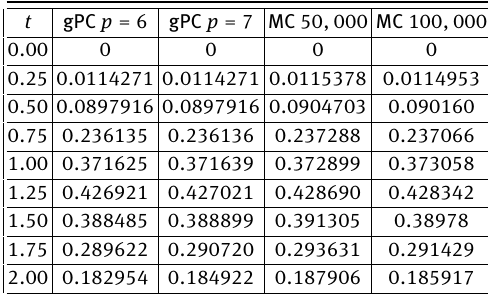
Table 8: Approximation of V [ X ( t )] . Example 4.2, assuming independent random data.